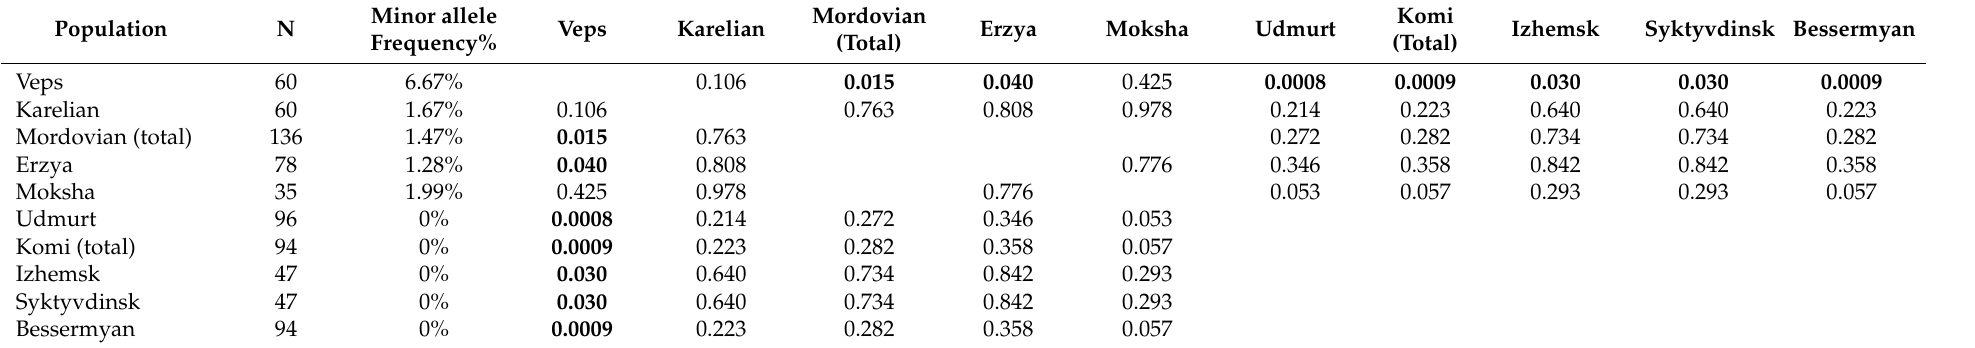
Table 9. Frequencies of the minor allele rs4986774 of the CYP2D6 gene in the studied samples of Finno-Permic